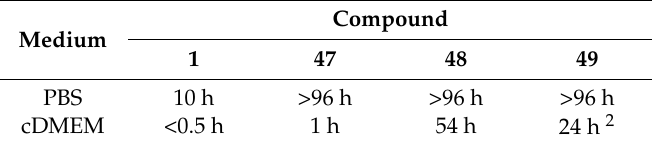
Table 7. Stability of quercetin-isopropyloxycarbonylmethoxy (POC) conjugates 47 – 49 compared to quercetin 1